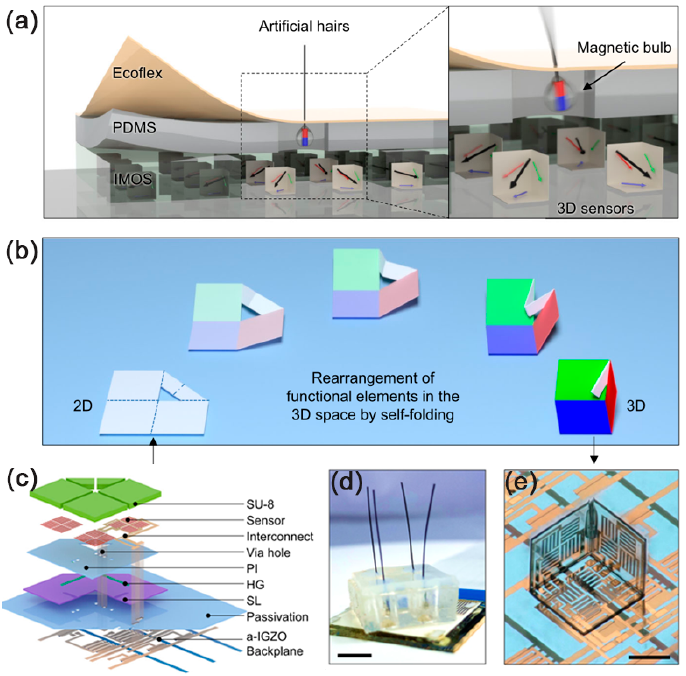
Figure 5. ( a ) Vision of the active matrix integrated micro-origami magnetic sensor for E-skin application; ( b ) Deterministic self-folding process; ( c ) Layout design of the self-foldable platform; ( d ) Photograph of the magnetic hair embedded e-skin system. Scale bar, 5 mm; ( e ) One pixel in the 3D sensor. Scale bar, 200 μ m. Adapted with permission from Ref. [34] and licensed under CC BY 4.0. Copyright 2022, copyright Springer Nature Limited.